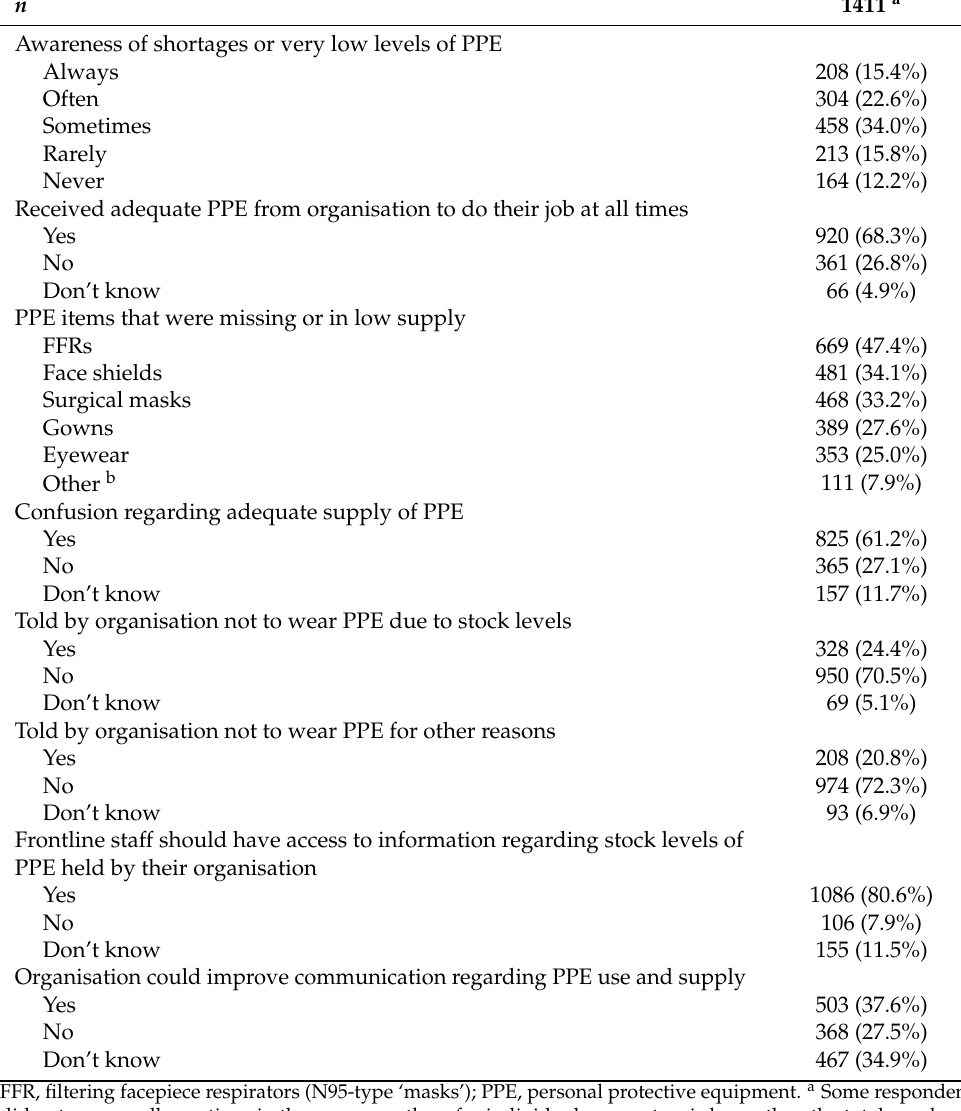
Table 2. Personal Protective Equipment (PPE) supply during COVID-19 surge one by respondents’ areas of